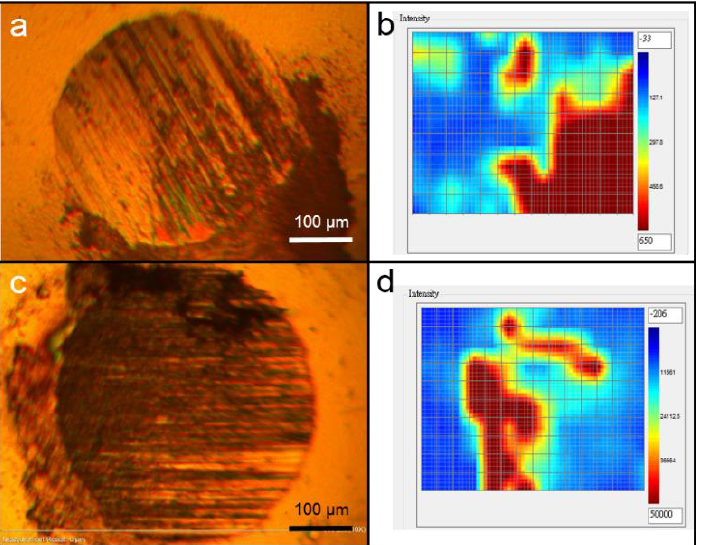
Figure 9. ( a ) OM image of chromium steel ball surface at a wear distance of 10 m; ( b ) Raman mapping image of ( a ); ( c ) OM image of chromium steel ball surface at a wear distance of 15 m; ( d ) Raman mapping image of ( c ).